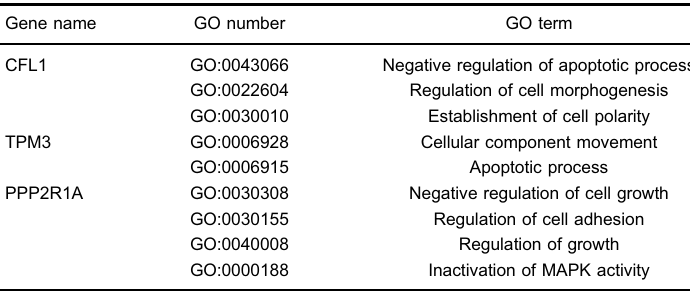
Table 2. Gene ontology (GO) analysis of peroxiredoxin 1 (Prx1) interacting